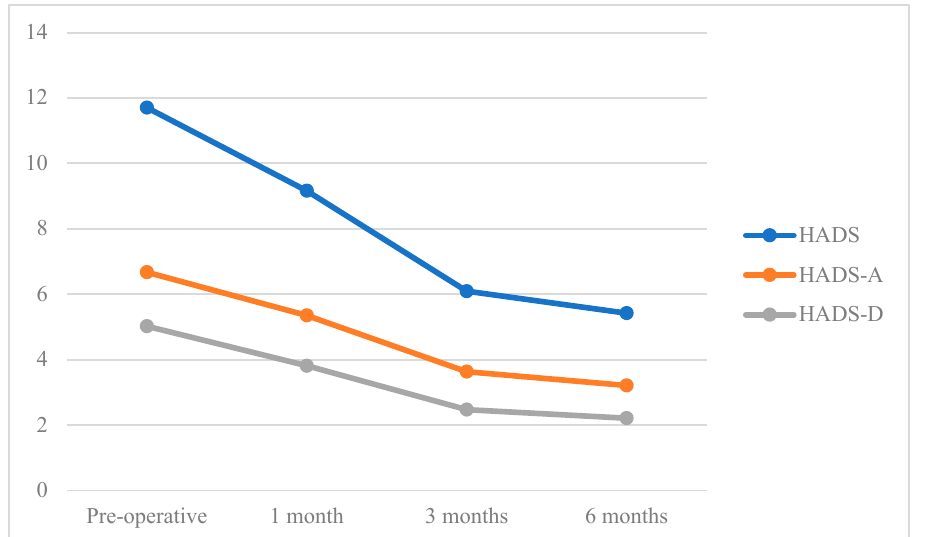
Figure 1. HADS, HADS-A and HADS-D follow-up. Table 1. Statistically significant changes for HADS, HADS-A, HADS-D, CMS, and